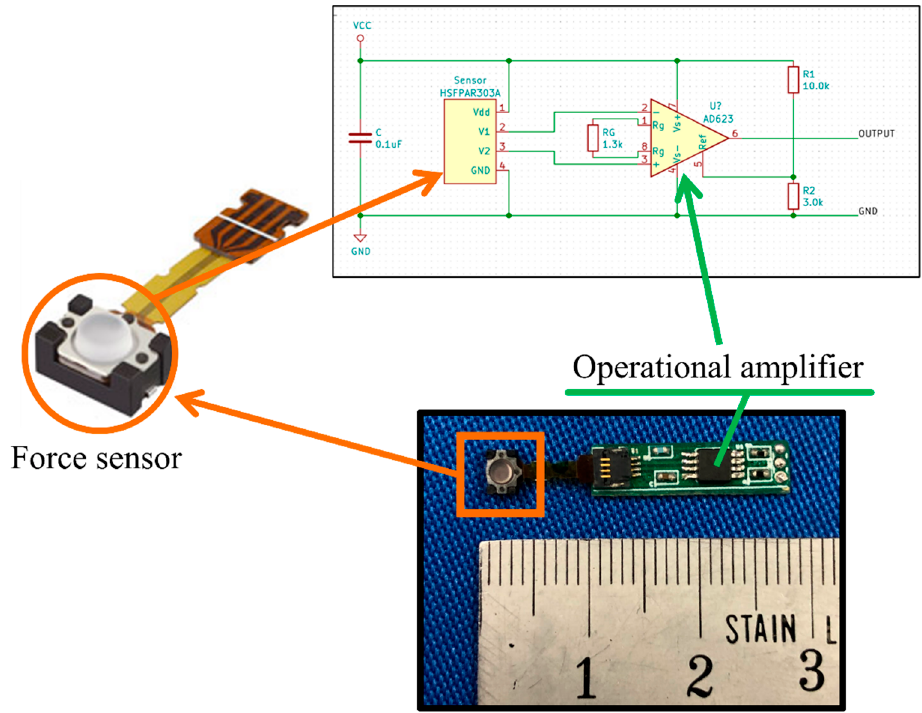
Figure 2. Modified force sensor internal circuitry.